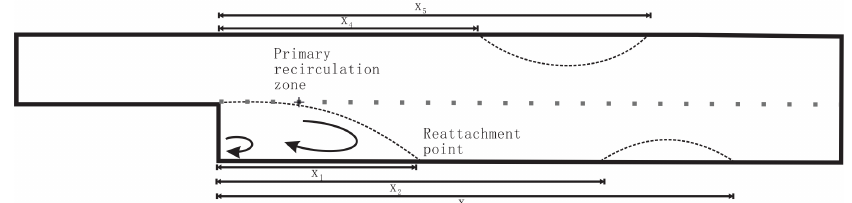
Figure 3. Flow through a backward facing step creates a number of flow attachment and detachment points downstream. The primary recirculation zone is located in front of the step with a length x 1 . Two other recirculation bubbles also form on the lower wall ( x 3 The dotted grey line corresponds to the centreline where virtual data probes were placed for monitoring velocity through time. The cross indicates the position at which instantaneous velocity signals were sampled through time (discussed in Section 3.5).